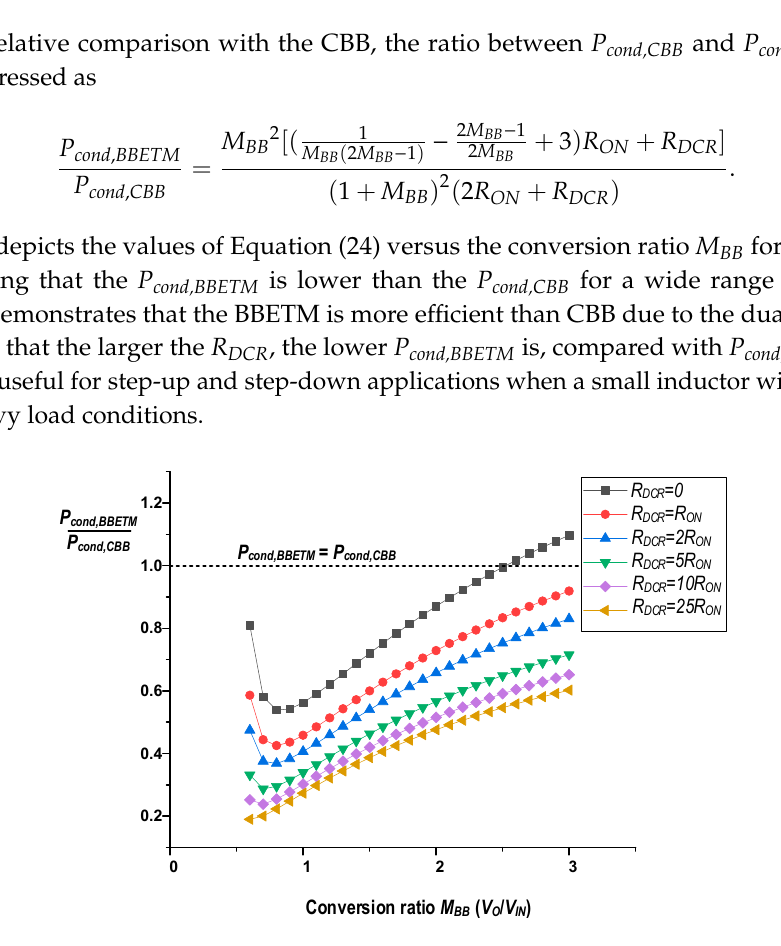
Figure 9. Conduction loss comparison of buck-boost converter with energy transfer media (BBETM) and conventional buck-boost (CBB) for different R DCR values.